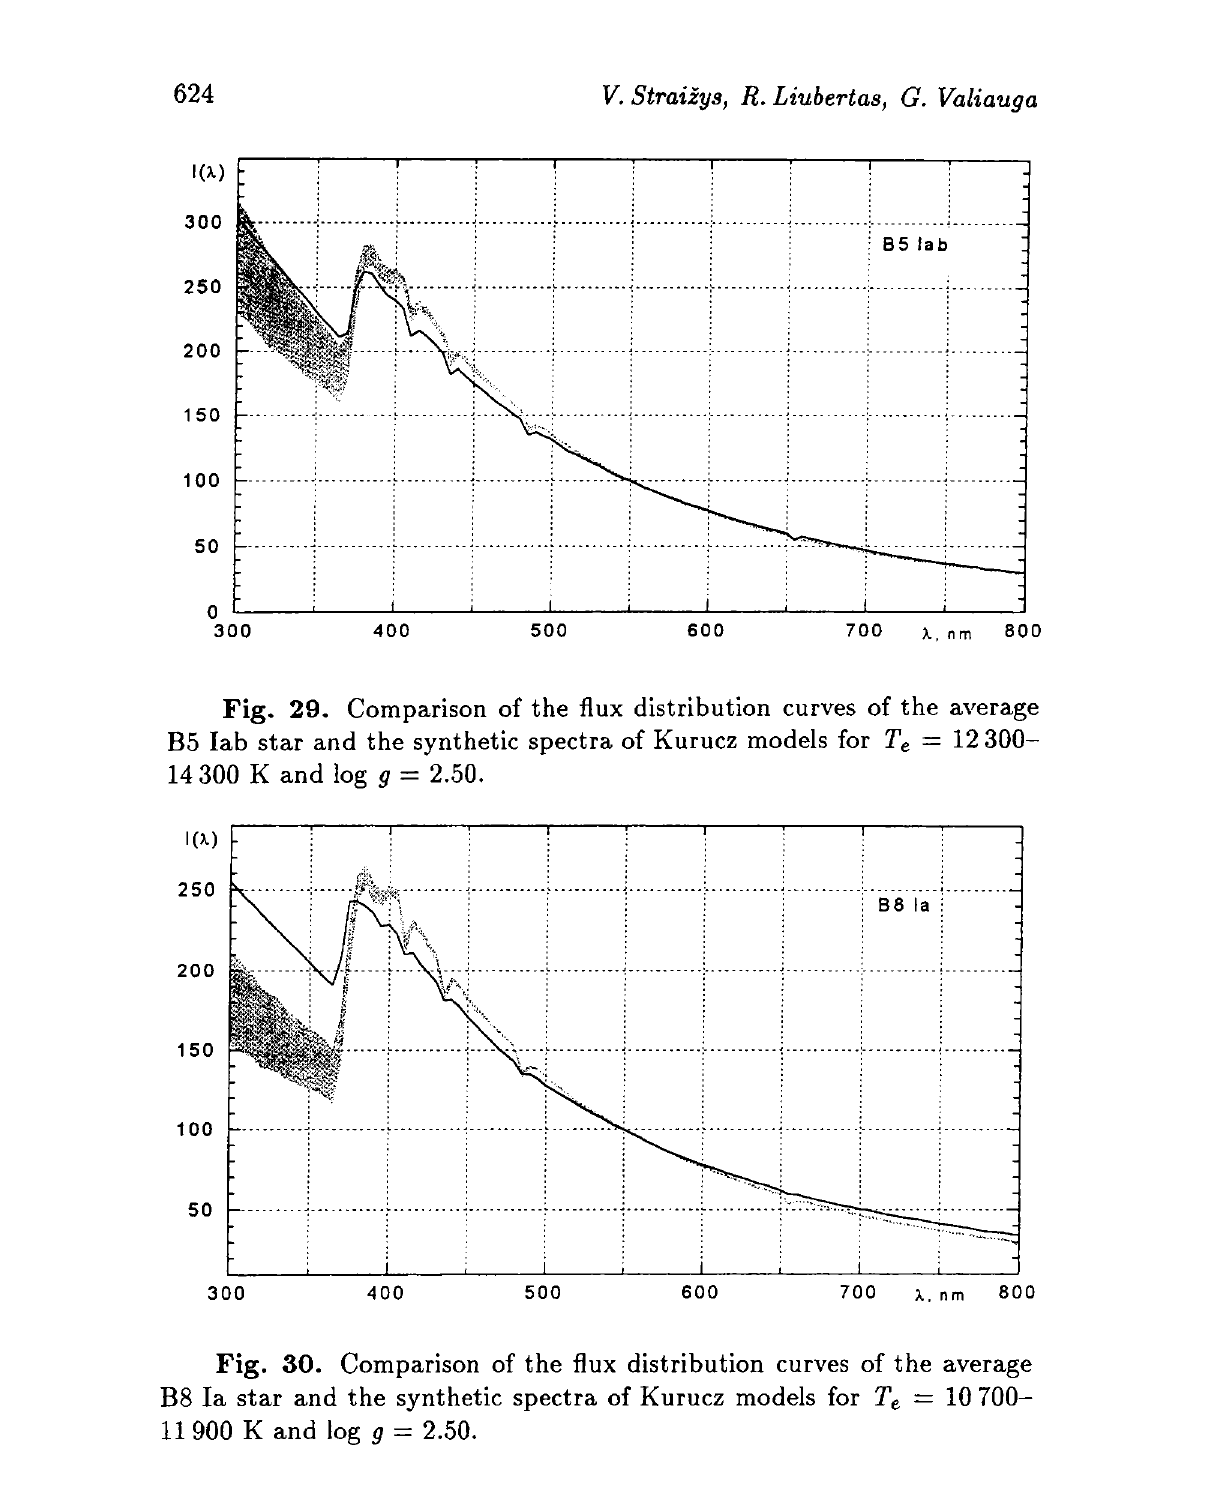
F i g. 30. Comparison of the flux distribution curves of the average B8 la star and the synthetic spectra of Kurucz models for T e = 10 700- 11900 K and log g =